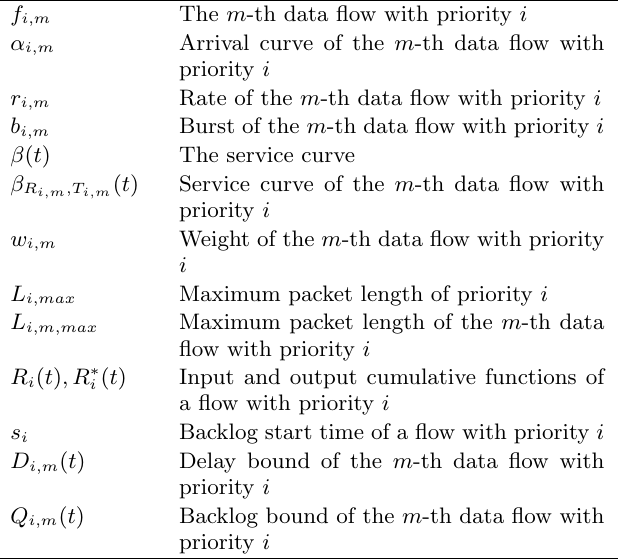
Table 1: Frequently Used